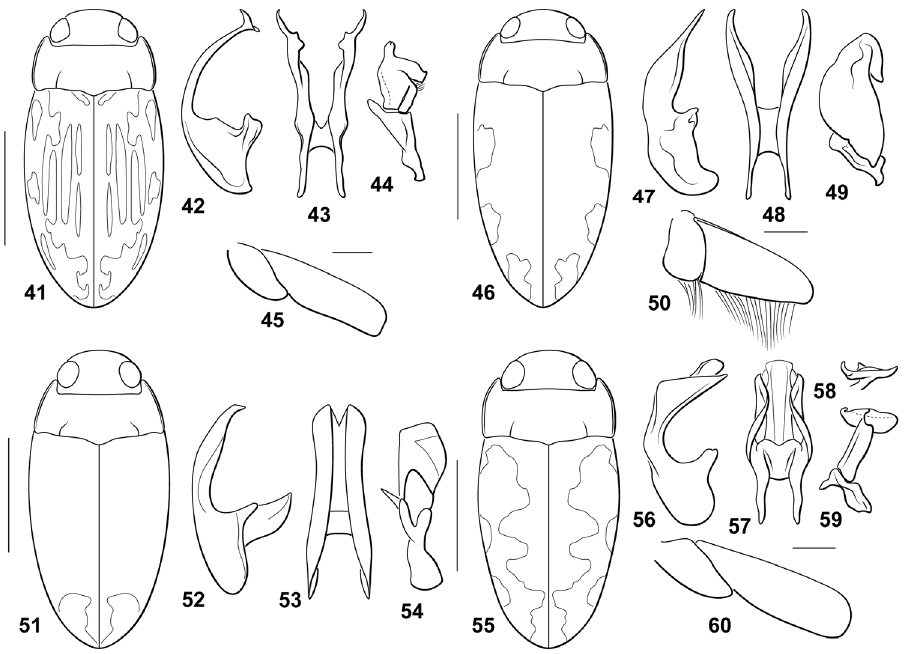
Figures 41–60. Bidessodes species. 41–45 B. evanidus 41 dorsal habitus, scale = 1 mm 42 male genitalia 42 median lobe, right lateral aspect 43 median lobe, ventral aspect 44 right lateral lobe, right lateral as- pect 45 left metatrochanter and metafemur, anterior aspect, scale = 0.25 mm 46–50 B. franki 46 dorsal habitus, scale = 1 mm 47 male genitalia 47 median lobe, right lateral 6spect 48 median lobe, ventral aspect 49 right lateral lobe, right lateral aspect 50 left metatrochanter and metafemur, anterior aspect, scale = 0.25 mm 51–54 B. hamadae 51 dorsal habitus, scale = 1 mm 52 male genitalia 52 median lobe, right lateral aspect 53 median lobe, ventral aspect 54 right lateral lobe, right lateral aspect 55–60 B. hy- grobius 55 dorsal habitus, scale = 1 mm 56 male genitalia 56 median lobe, right lateral aspect 57 median lobe, ventral aspect 58 right lateral lobe apex, apical aspect 59 right lateral lobe, right lateral aspect 60 left metatrochanter and metafemur, anterior aspect, scale = 0.25